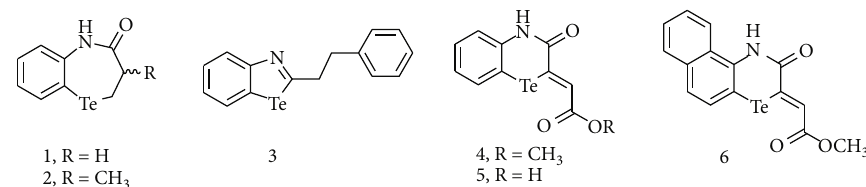
Figure 4: Products prepared in this study.